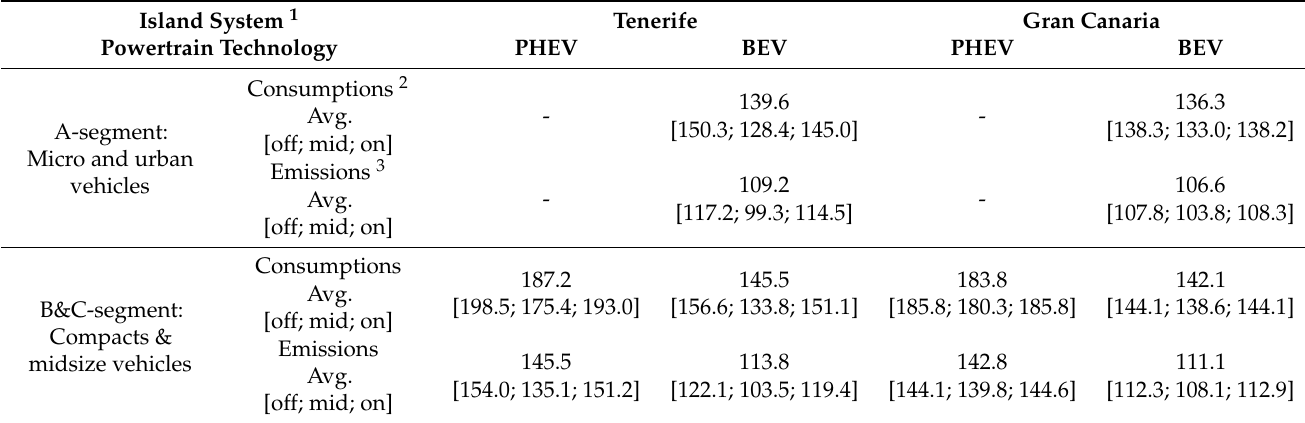
Table 6. The WtW results for PEVs in big-size systems (Tenerife and Gran Canaria in